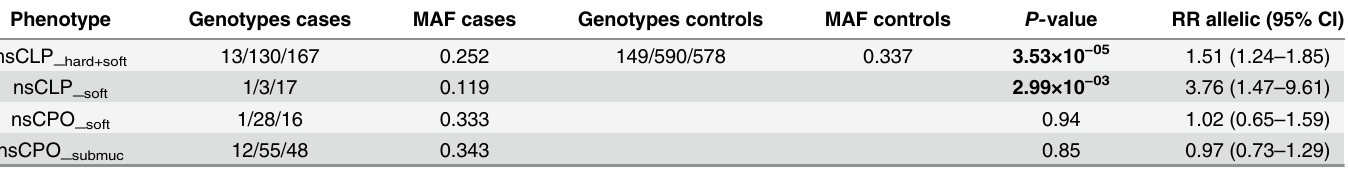
Table 2. Analysis of rs1258763-subphenotype effect on the soft